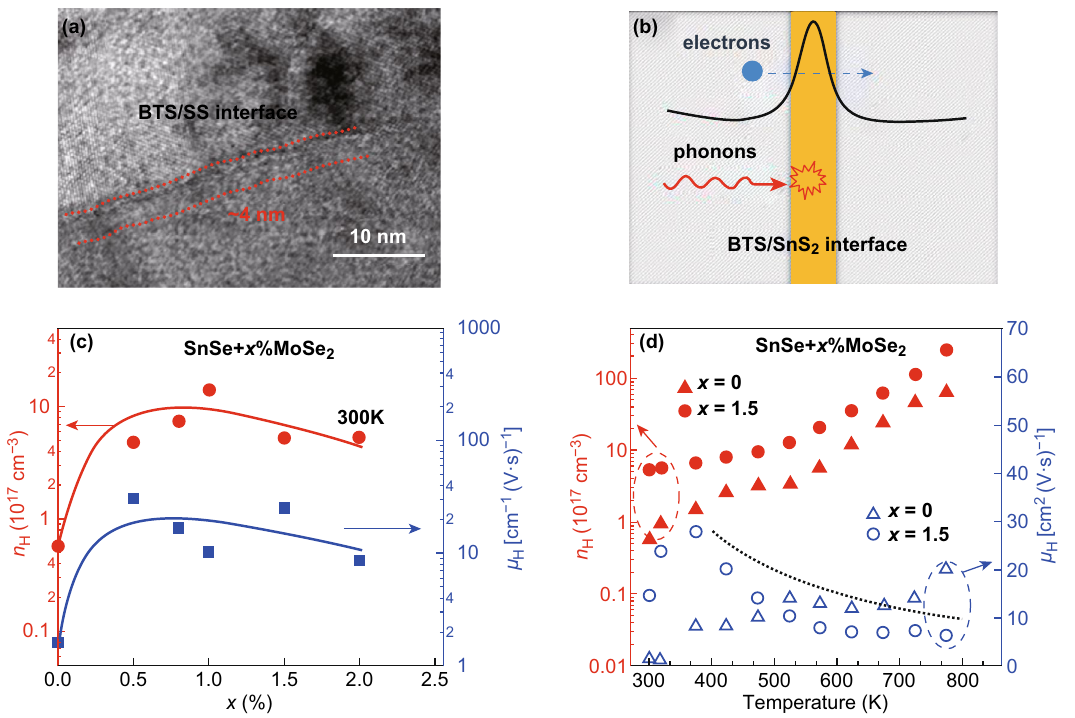
Fig. 10 a HRTEM image of the Bi 2 Te 2.7 Se 0.3 /SnS 2 bulk; b mechanisms that contribute to the high ZT value of the Bi 2 Te 2.7 Se 0.3 /SnS 2 nano- composites. Reproduced with permission from Ref. [196]. Copyright 2017, Elsevier. c Carrier concentration and mobility of the SnSe/MoSe 2 composites at 300 K as a function of the MoSe 2 content. d Temperature dependence of carrier concentration and of the carrier mobility of SnSe/ MoSe 2 . Reproduced with permission from Ref. [197]. Copyright 2017, IOP